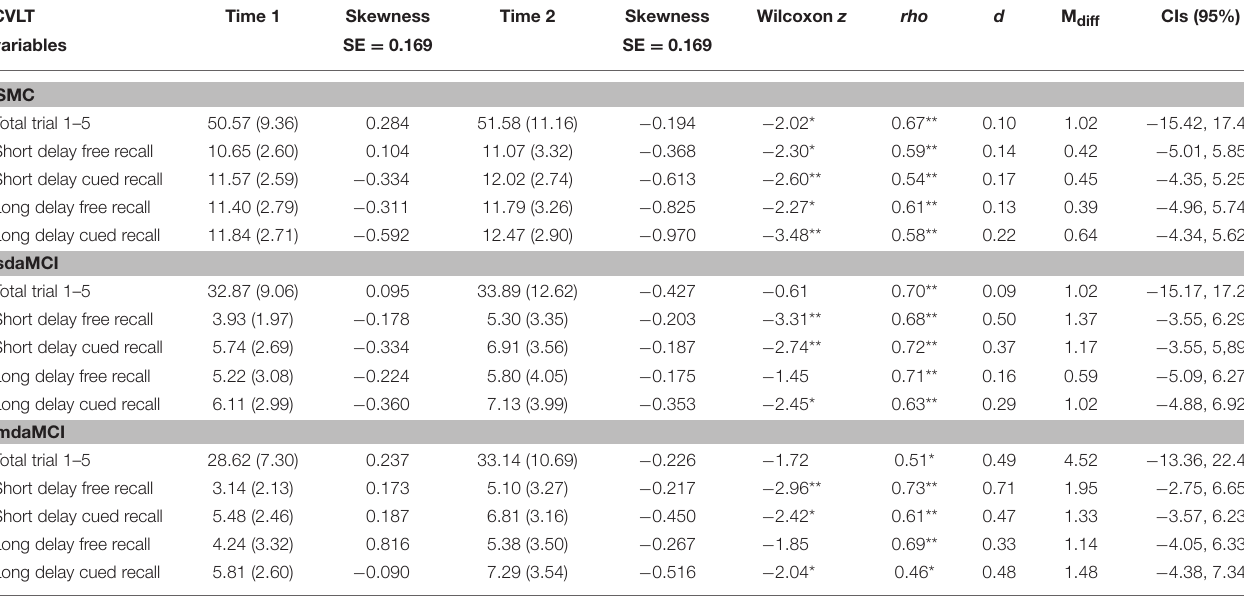
TABLE 2 | Test-retest data for the Spanish version of CVLT in the group with subjective memory complaints but without cognitive impairment (SMC), single-domain amnestic mild cognitive impairment group (sda-MCI), and multi-domain amnestic mild cognitive impairment group (mda-MCI).